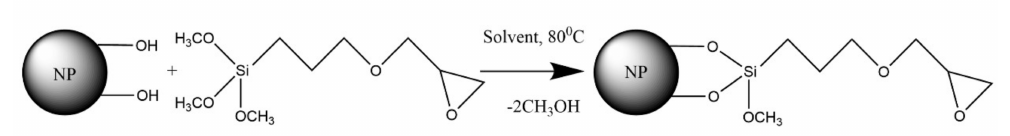
Figure 3. Glycidyl spacer synthesis